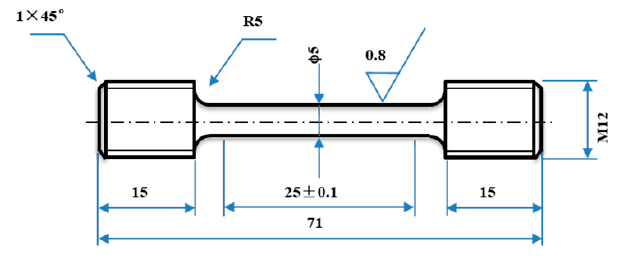
Figure 3. Dimension of tensile specimen.